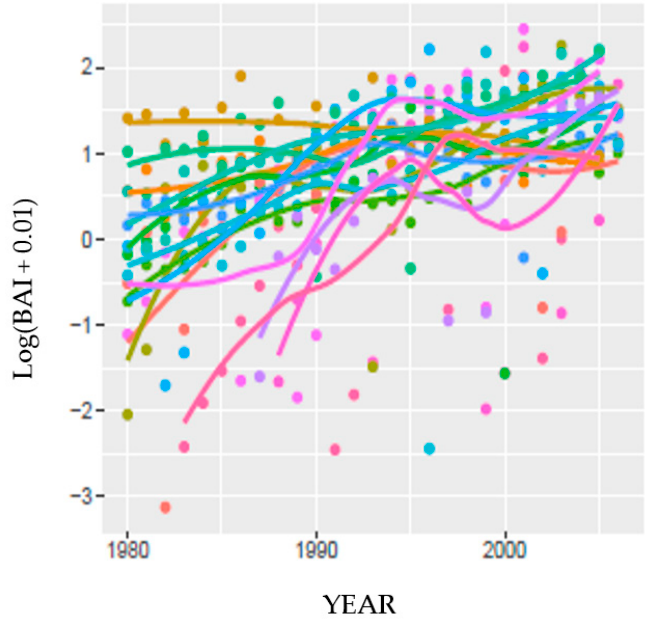
Figure 5. Log(BAI + 0.01) at HM vs. year for a subset of trees showing different patterns of tree bole growth at the same site.